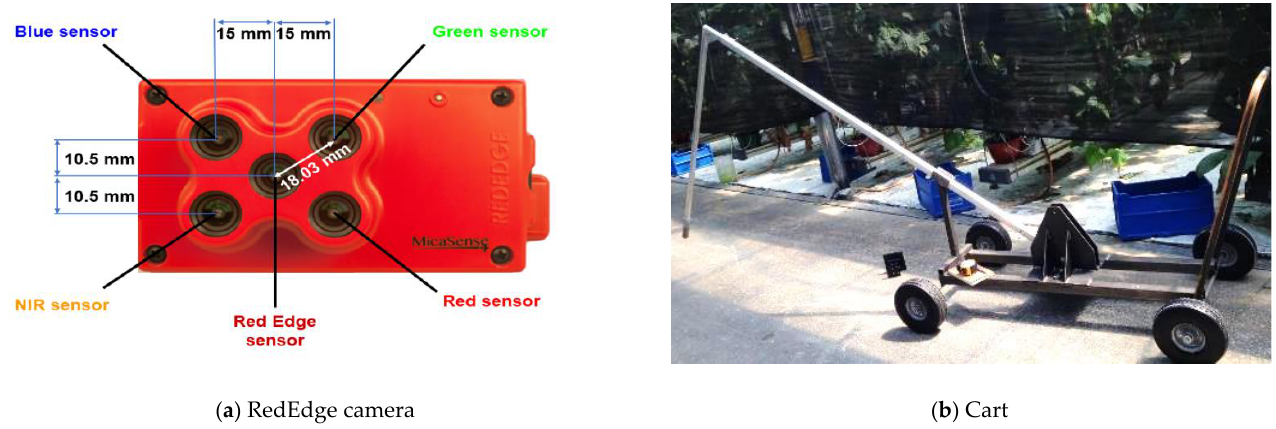
Figure 2. ( a ) Micasense ® RedEdge camera and related distance between the five sensors (adapted from www.dronenerds.com (accessed on 10 December 2020)); ( b ) Designed cart for image acquisition. Table 1. Spectral information of each band from the Micasense ® RedEdge camera.